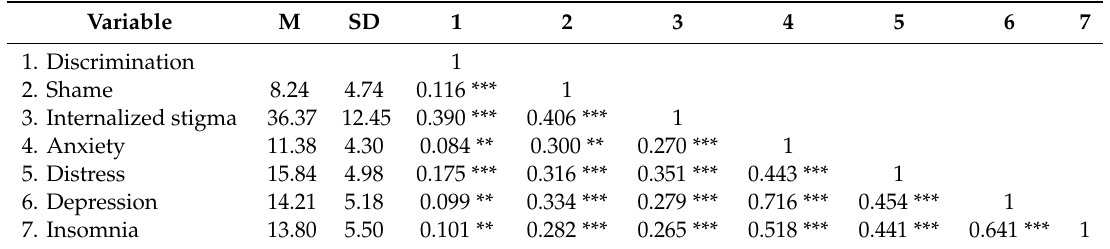
Table 2. Means, standard deviations, and bivariate correlations among